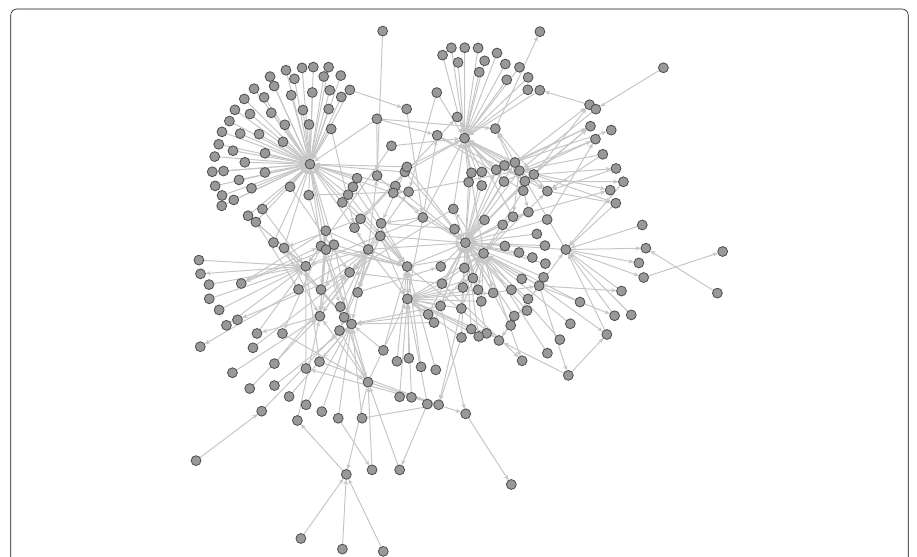
Fig. 4 Pairwise dominance ordering based on third-party edits among contributing users of the Wikipedia article “The Third Man”. The layout has been determined with stress minimization and shows only the largest connected component of the